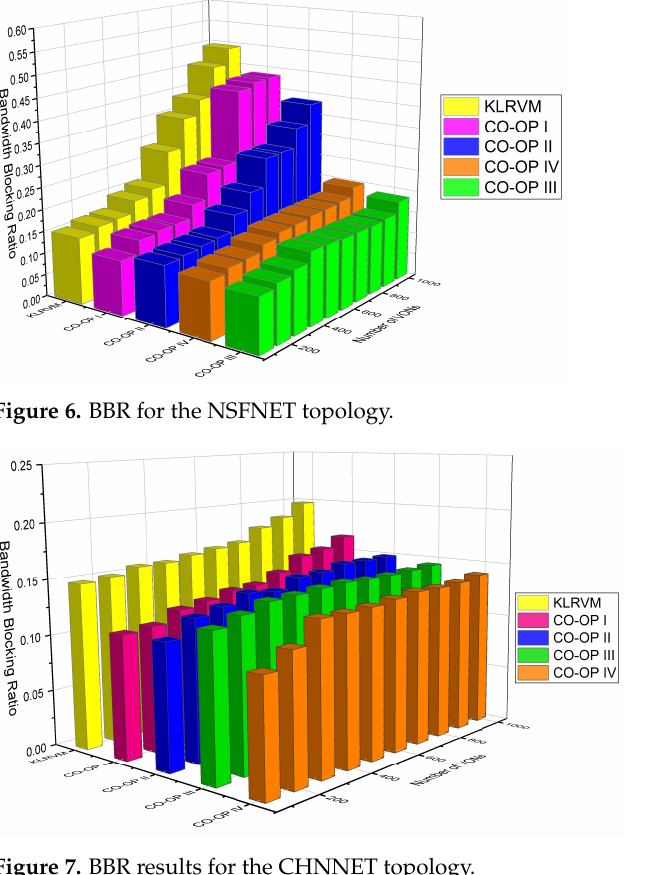
Figure 7. BBR results for the CHNNET